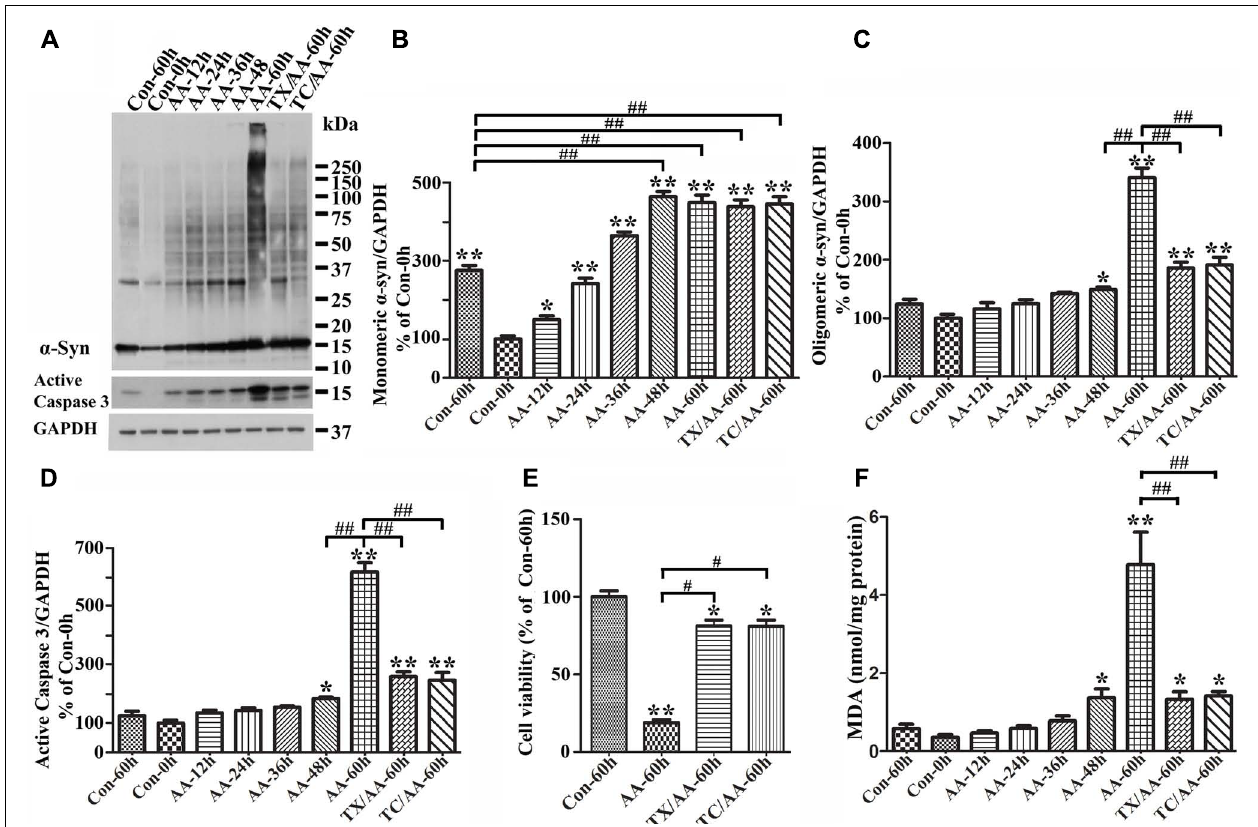
results showed more α -syn oligomers and active caspase 3 in cultures with 60 h of AA treatment, and such increase was reduced in cultures co-treated with AA plusTX orTC. (E) Calcein assay of con-60h, AA-60h,TX/AA-60h, and TC/AA-60h cultures. Results showed that AA-induced death can be blocked significantly by co-treatment withTX orTC. (F) LPO assay for all samples, demonstrating a significant increase of LPO levels after 48 h or longer exposure of cultures to AA when compared to controls (compared AA-48 to con-0h). Such changes were reduced significantly byTX orTC co-treatment. The results are representative of three independent experiments. Error bars represent SEM. Number sign(s) marked significant differences between two groups linked by bracket ( # p < 0.05, ## p < 0.01). Asterisk(s) indicated significant differences between the treated group and Con0h (* p < 0.05, ** p <